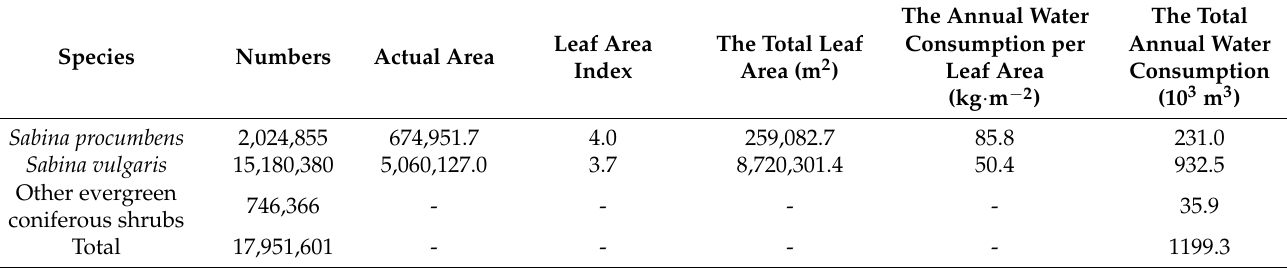
Table 13. Annual water consumption of evergreen coniferous shrubs in